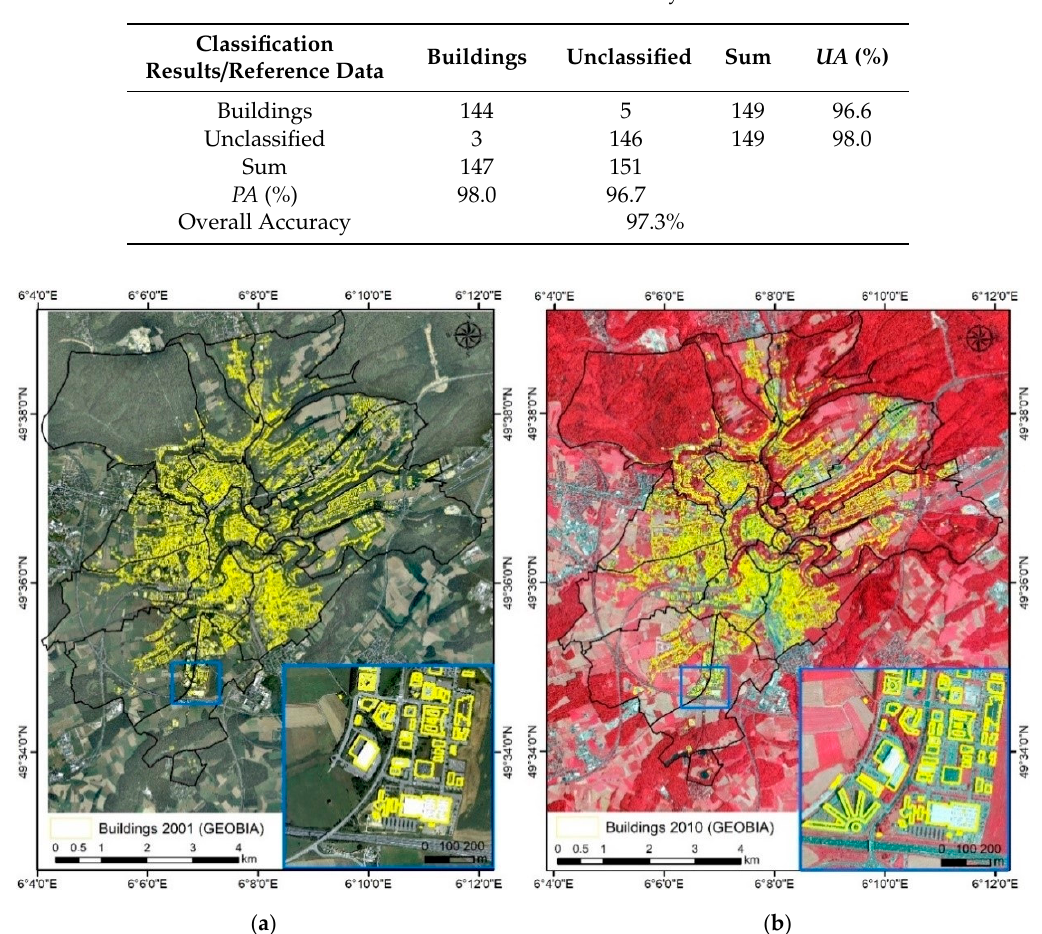
Table 3. Error matrix for the GEOBIA analysis in 2010.